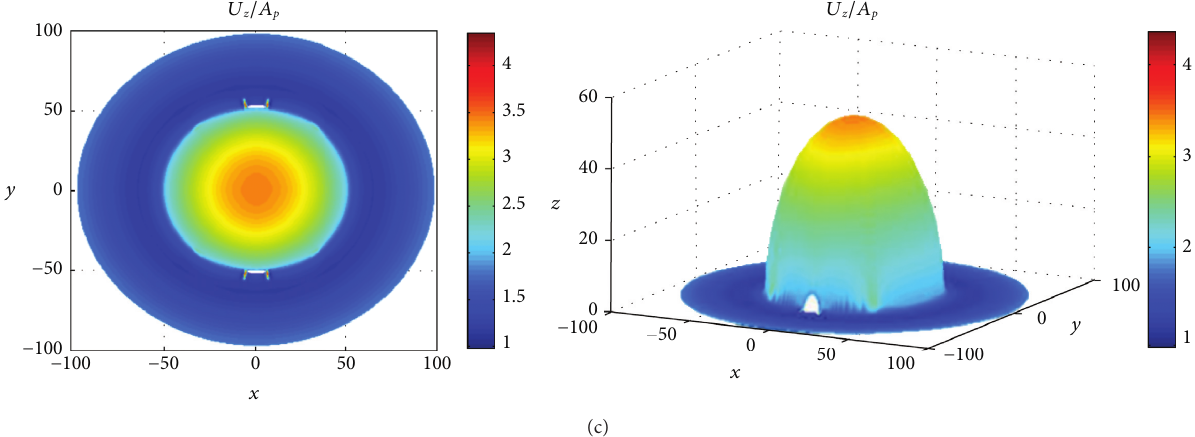
Figure 3: Surface displacement amplitude of the 3D tunnel mountain under the incident P wave ( η � 0 . 5 , α � 0 ° ): (a) surface displacement amplitude in x direction; (b) surface displacement amplitude in y direction; (c) surface displacement amplitude in z